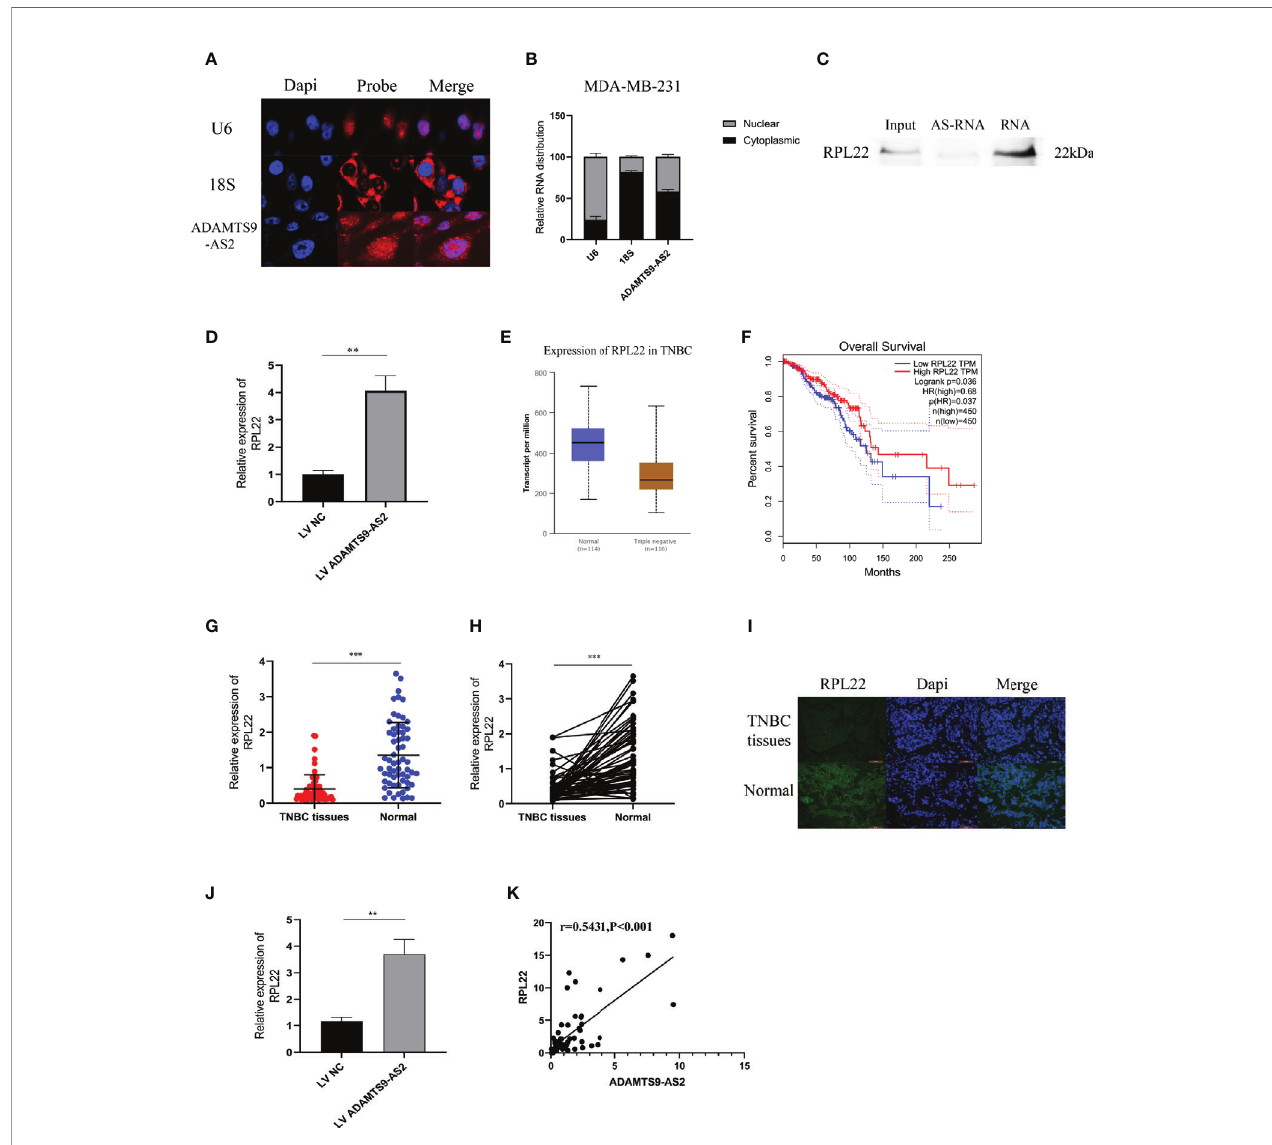
FIGURE 5 | ADAMTS9-AS2 interacts with RPL22 in TNBC cells to suppress tumor progression. (A) FISH analysis of the location of ADAMTS9-AS2 in the cytoplasm and nuclear fractions of MDA-MB-231 cells. (B) qRT-PCR was used to detect ADAMTS9-AS2 subcellular fractionation. (C) RNA pull-down assay indicated that ADAMTS9-AS2 interacted with RPL22. (D) Western blot proved the relationship between ADAMTS9-AS2 interacted with RPL22. (E) Relative expression of RPL22 in TNBC tissues (Tumor) compared with normal tissue (normal) was analyzed using TCGA data. (F) Kaplan-Meier survival analysis of overall survival based on TCGA data. (G) Relative expression of RPL22 in TNBC tissues (Tumor) and adjacent non-tumor tissues (Normal) was determined by qRT-PCR (n = 62). (I) IF was used to demonstrate the relative expression of RPL22 in TNBC tissues. (J) Relative expression of RPL22 in xenograft tumors of each group was determined by qRT-PCR. (K) Spearman – Pearson correlation of ADAMTS9-AS2 and RPL22. **P < 0.01, ***P <